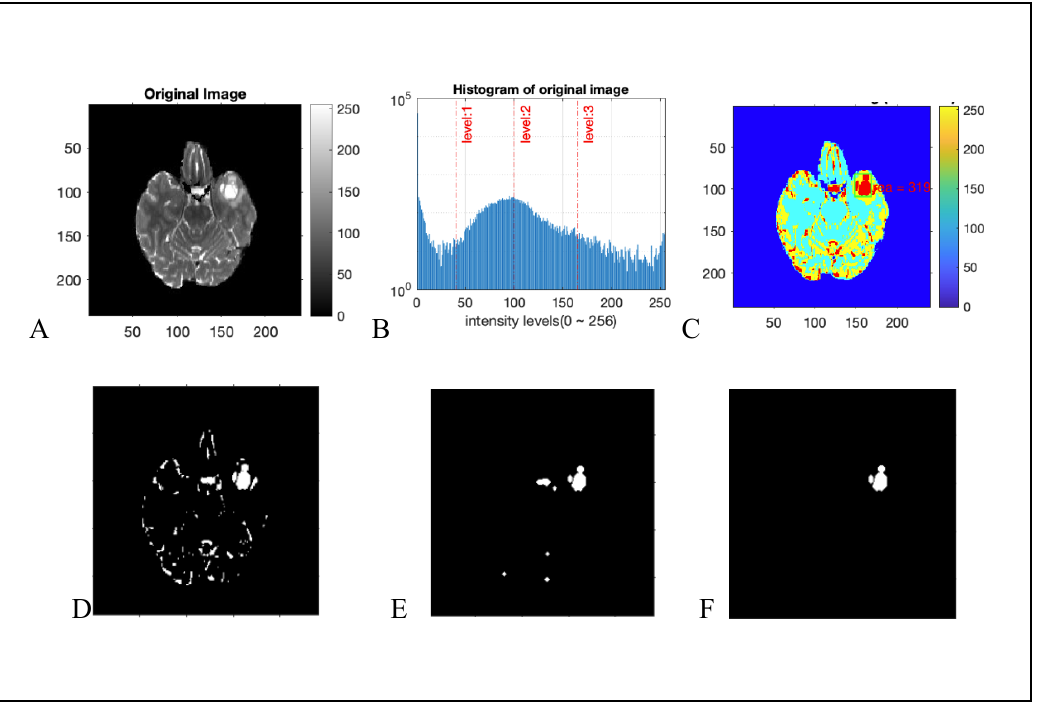
coded image. ( D ) Display the red-colored pixels in the image ( C ). ( E ) shows the result after morpho- logical processing. ( F ) show the fi nal result after connected component